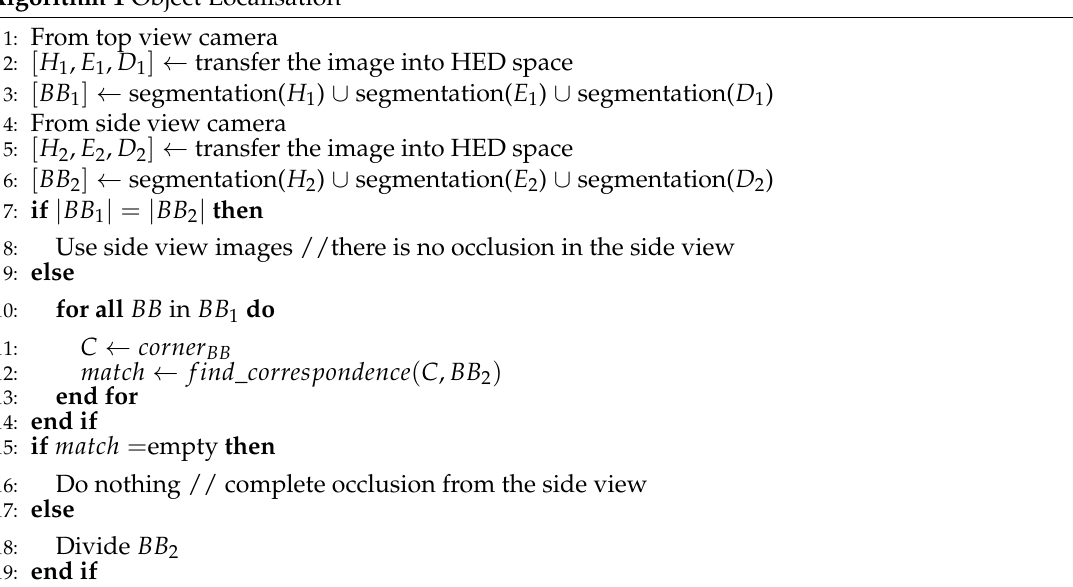
Figure 3. Top row : histogram of pixels in Haematoxylin-Eosin-DAB (HED) color space for 4 different scenes; Second row : Haematoxylin component of the input RGB image; Middle row : Eosin component of the input RGB image; Fourth row : binary image with all the segmented objects after applying a threshold value in each HED component; Bottom row : bounding box of each region of interest. Algorithm 1 Object